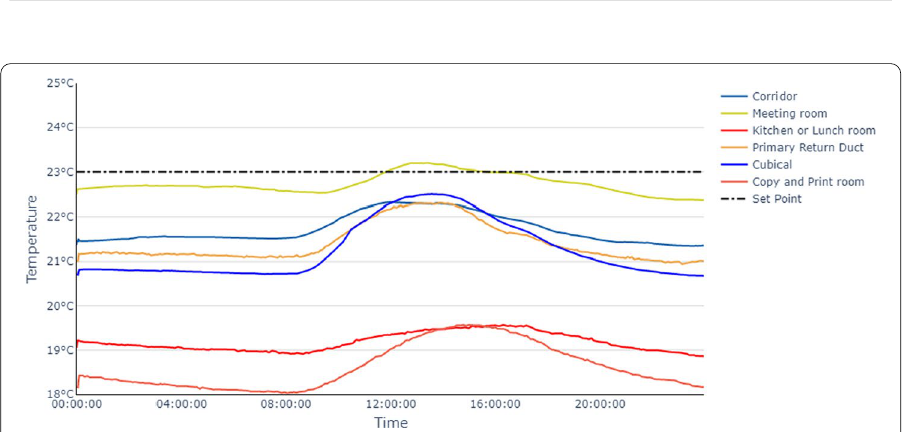
Fig. 2 Temperature variations over the entire test period for floor 1. Green color box shows the comfortable temperature